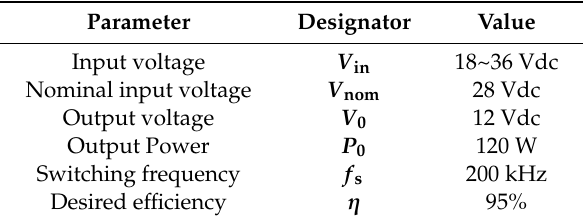
Table 1. Specifications for 120 W Active-Clamp